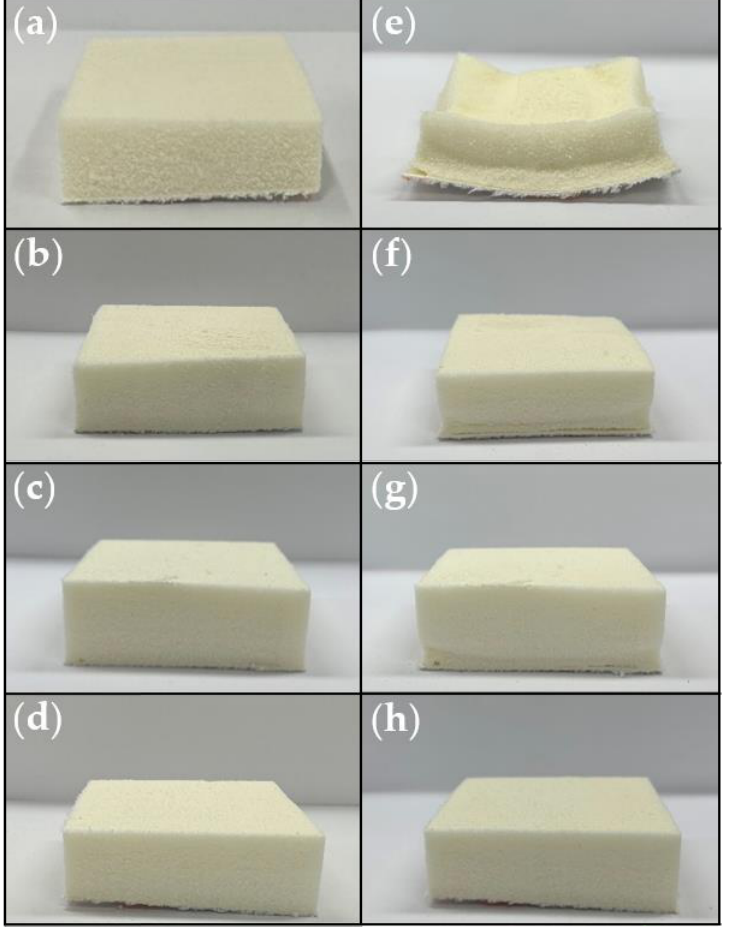
Figure 9. The picture of PU foams with samples ( a ) N, ( b ) C0.25, ( c ) C0.5, ( d ) C1 at day 1, and ( e ) N,